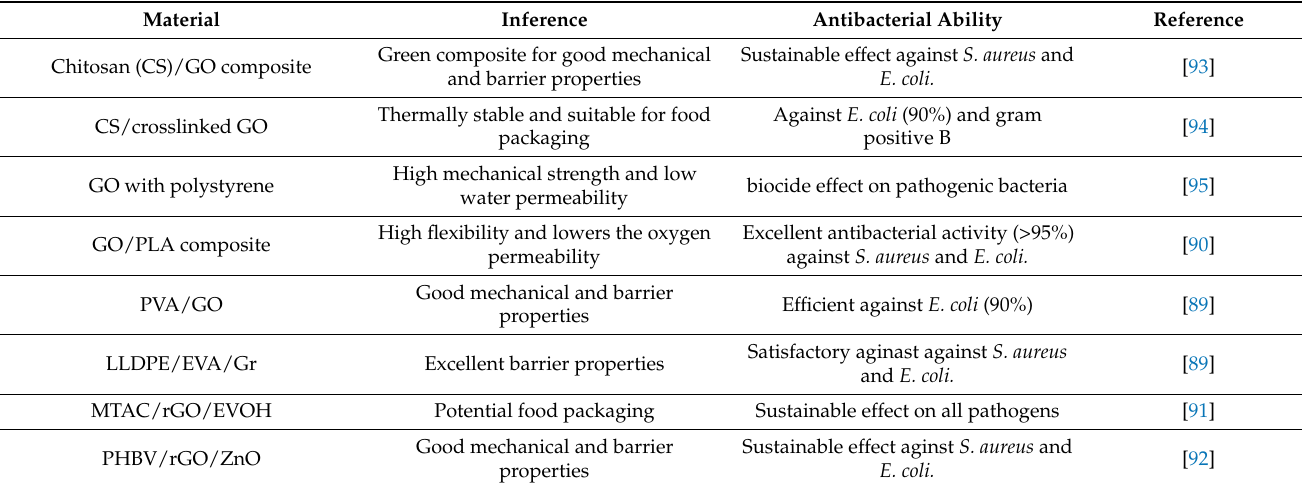
Table 2. Examples of graphene-based materials for food